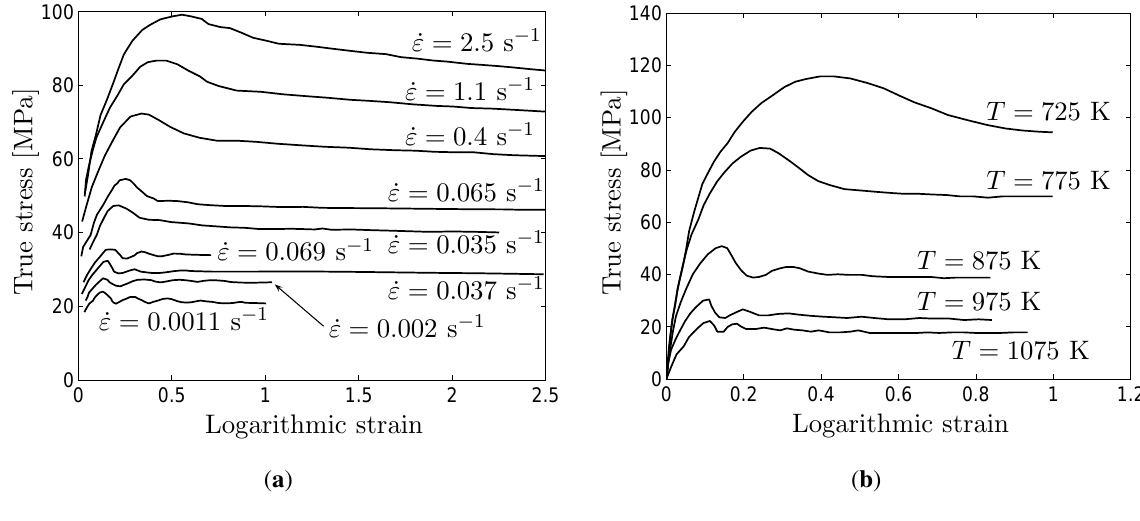
Figure 1. ( a ) Flow stress behavior of 0.25% carbon steel at a constant temperature of 1100 C under varying strain-rates. Experimental results taken from [10]; ( b ) Flow ◦ stress behavior of OFHC copper obtained at a constant strain-rate of 2 × 10 under different temperatures. Experimental results taken from [11]. In both ( a ) and ( b ) recrystallization-induced transitions from single-peak flow stress behavior to oscillatory flow are